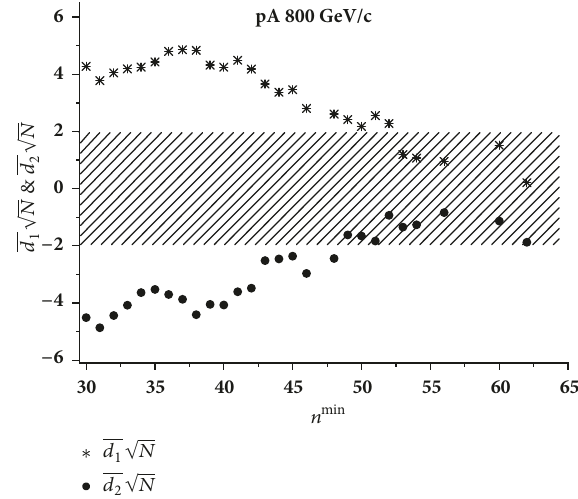
Figure 1: Dependence of parameters 𝑑 1 √𝑁 and 𝑑 2 √𝑁 on 𝑛 𝑚𝑖𝑛 for proton-nucleusinteractionsinemulsionat 800 GeV.Theshadedarea is the area where |𝑑 1 √𝑁| & |𝑑 2 √𝑁| < 2 .